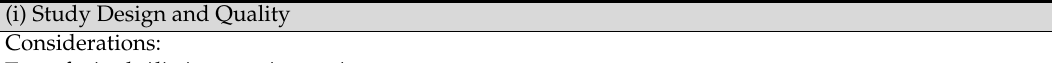
Table 6. Proposed framework for scientific evidence assessment of microbiota-based dietary